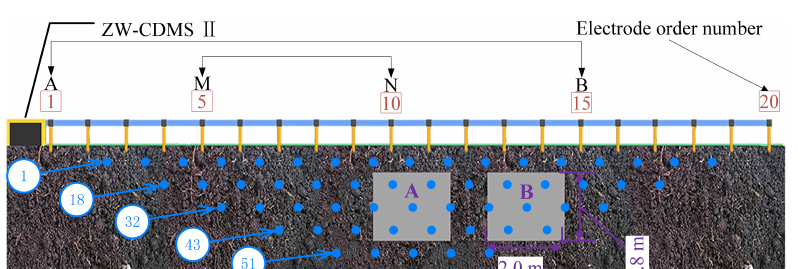
Figure 10. Diagram of the field test.